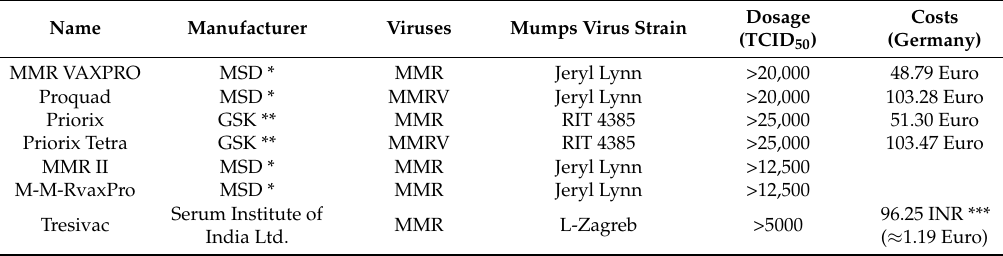
Table 1. Measles, mumps, rubella (German pox) (MMR) and measles, mumps, rubella, varicella (chicken pox) vaccines (MMRV) available in